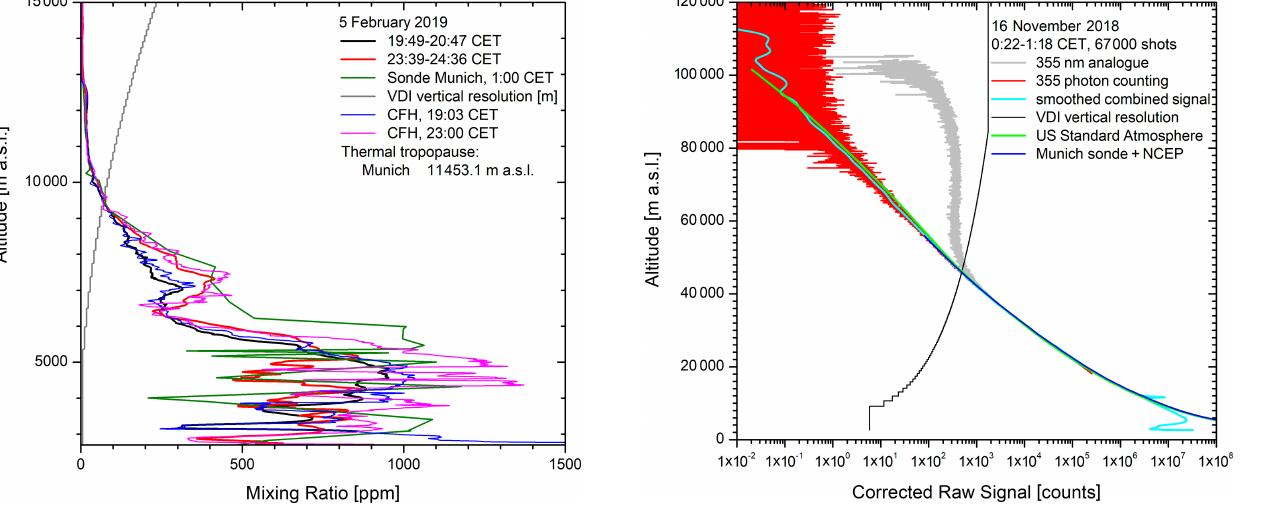
Figure 15. Vertical distributions of water vapour derived from two measurements of the Raman lidar on 5 February 2019 together with those from the midnight Munich sonde and the CFH sensors; the CFH data in the upper troposphere were used for calibration.